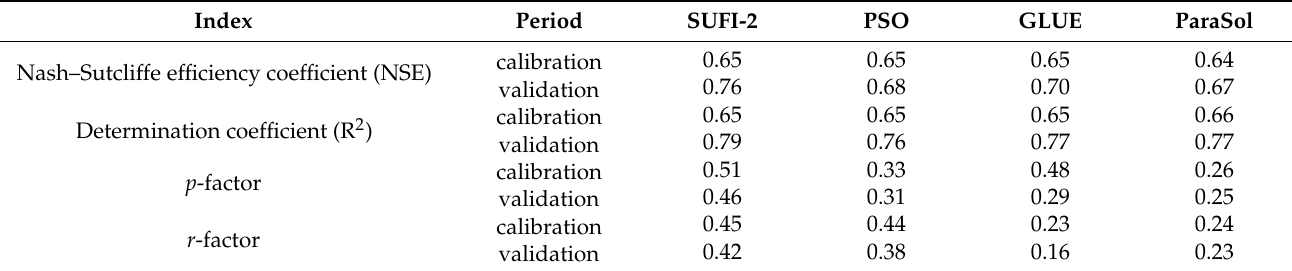
Figure 2. Outlet site USGS02295637 in the calibration (2001–2014) and validation (2015–2018) periods: ( a ) observation and simulation runoff; ( b ) behavior parameter probability density distributions of the four uncertainty methods: the sequential uncertainty fitting version (SUFI-2), generalized likelihood uncertainty estimation (GLUE), parameter solutions (ParaSol), and particle swarm optimization (PSO). Table 3. Evaluation indexes of the simulation results in the calibration period (2001–2014) and the validation period (2015–2018).